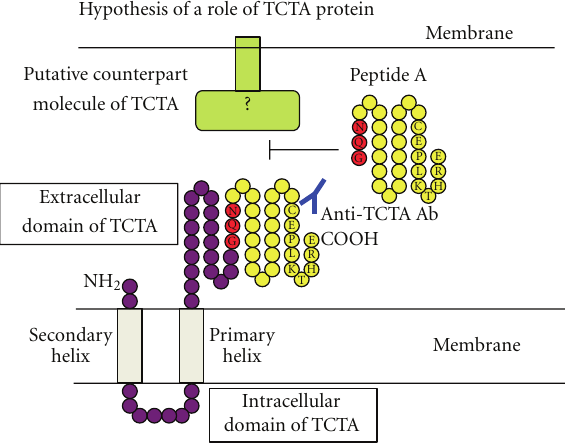
Figure 2: Possible mechanism of human osteoclastogenesis by peptide A and antibodies against TCTA protein. (Structure of TCTA is derived from SOSUI; http://bp.nuap.nagoya-u.ac.jp/sosui/ sosui submit.html). TCTA protein plays an important role in cellular fusion in human osteoclastogenesis from monocytes and mature osteoclasts. Both peptide A and antibodies block the in- teraction between TCTA protein and a putative counterpart of TCTA protein.Modified from the figure in